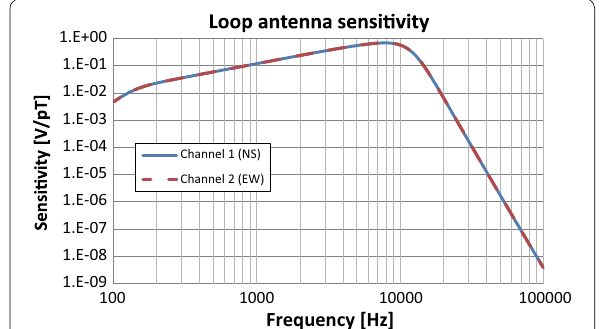
Fig. 12 Frequency dependence of sensitivities of the loop antenna to measure the ELF/VLF radio waves